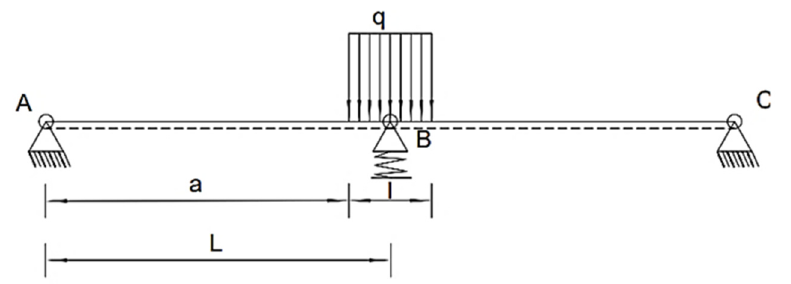
Figure 8. Abstract model of the floating bridge.